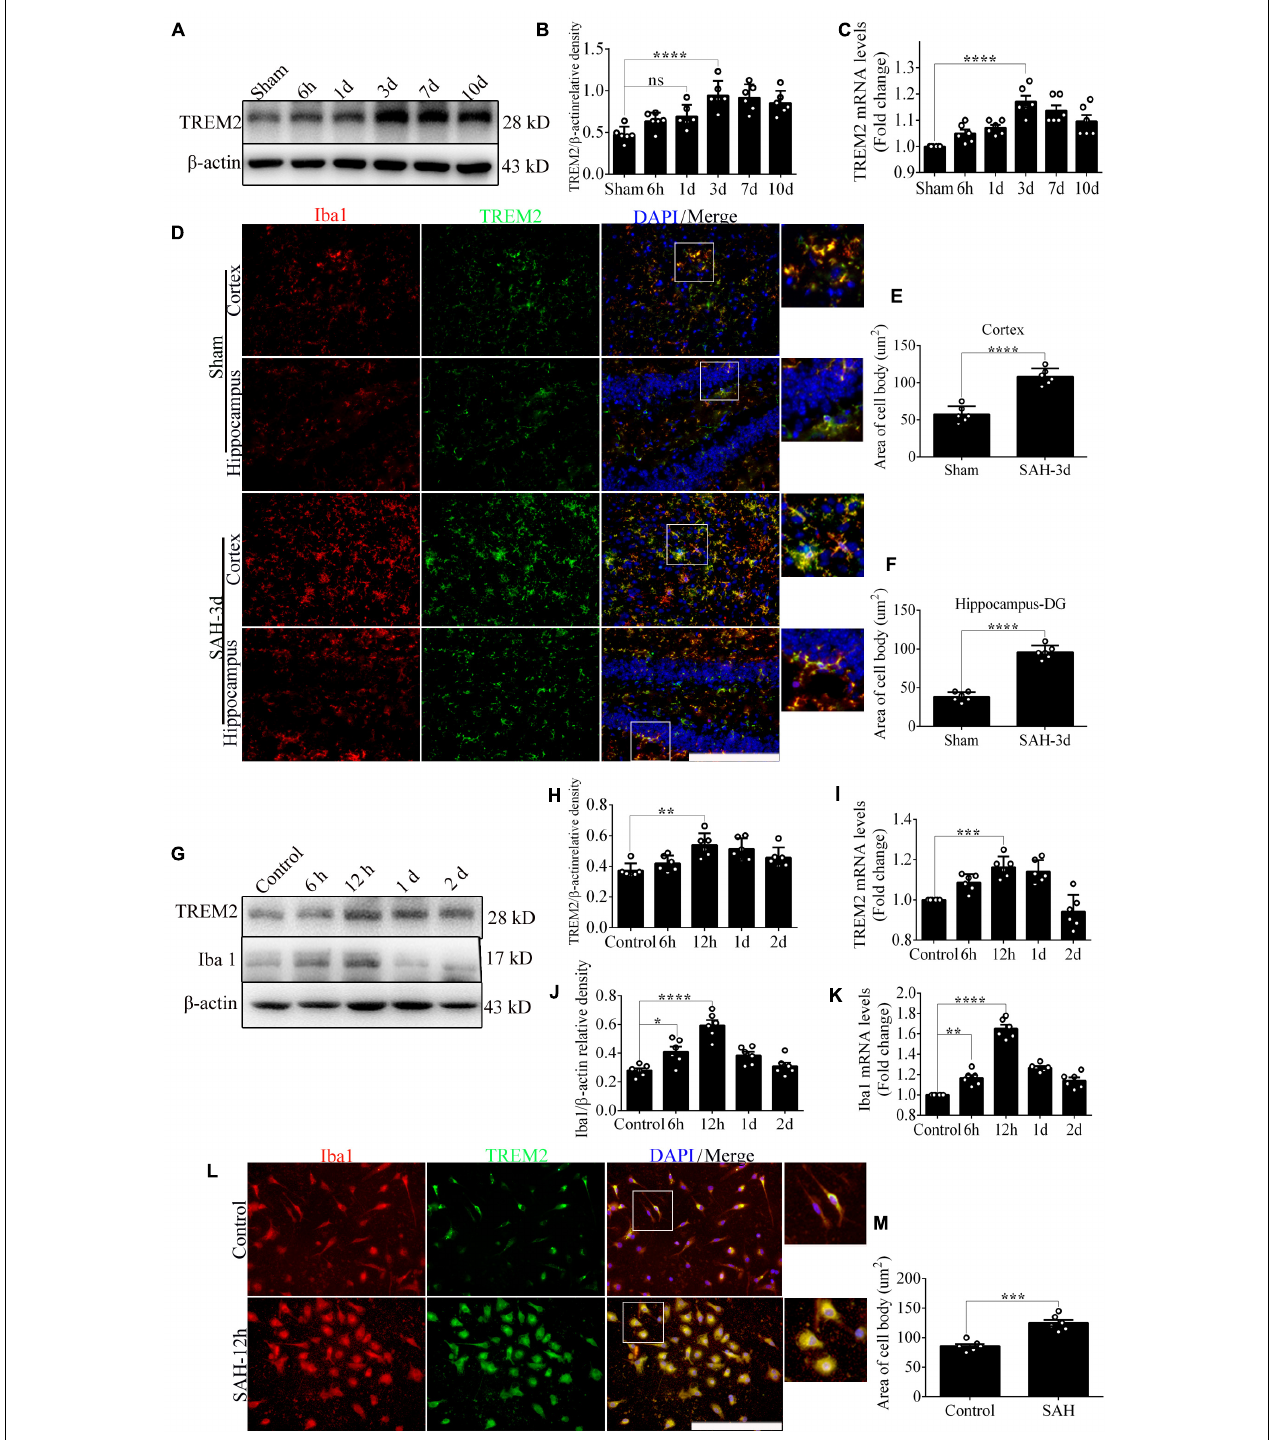
FIGURE 1 | The endogenous levels of triggering receptor expressed on myeloid cells 2 ( TREM2 ) in vivo and in vitro after subarachnoid hemorrhage (SAH). (A–C) Representative Western blot bands and quantitative analyses of TREM2 time course in vivo after SAH. (D–F) Co-localization of TREM2 with ionized calcium-binding adaptor molecule 1 (Iba1) was observed and quantified both in the cortex and hippocampus at 3 days after SAH. (G–K) Representative Western blot bands and quantitative analyses of TREM2 and Iba1 time course in vitro after SAH. (L,M) Co-localization of TREM2 with Iba1 was observed and quantified in primary microglia at 12 h after SAH. These data are shown as mean ± SEM ( n = 6/group; * p < 0.05, ** p < 0.01, *** p < 0.001, **** p < 0.001; scale bar = 25 µ m).